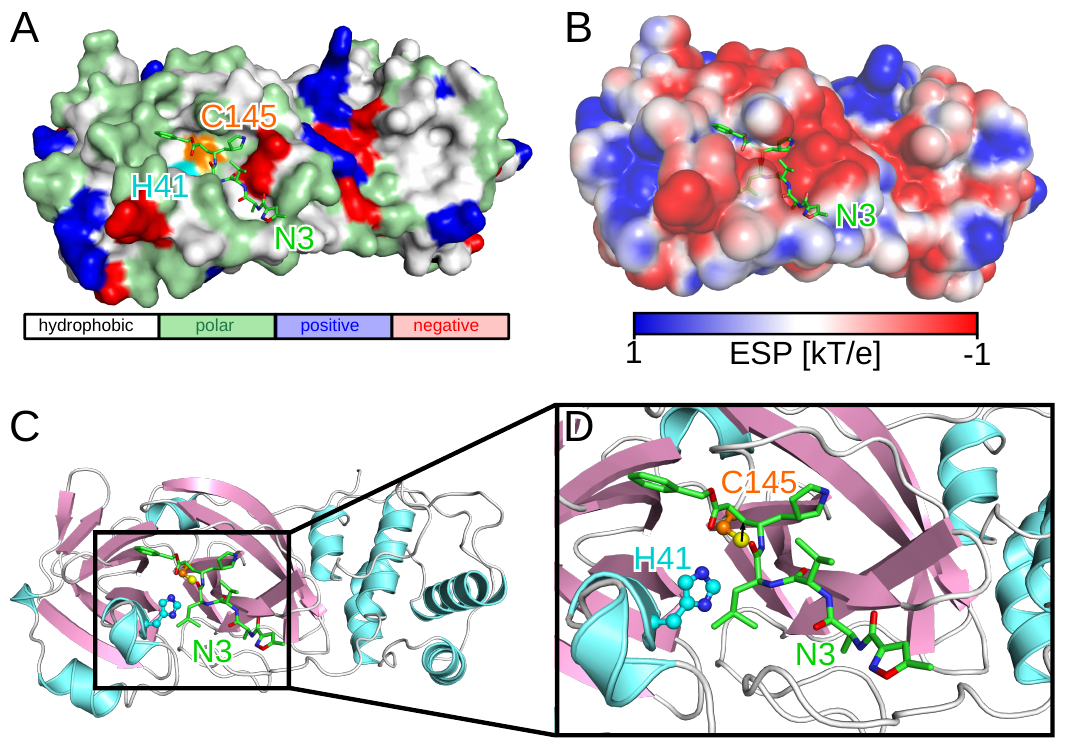
Figure 1. Structure and binding site of 3CL pro including the ligand N3 (PDB code 6LU7). ( A ) The surface of 3CL pro is shown and colored according to residue type using the color code given at the bottom. The catalytic dyad residues H41 and C145 are colored in cyan and orange, respectively. The stick representation is used for N3, which is colored in green with red and blue for the O and N atoms, respectively. ( B ) Another surface representation of 3CL pro but now colored according to the electrostatic potential using the color code given at the bottom (in kT with k being the Boltzmann constant, created with the Adaptive Poisson–Boltzmann Solver (APBS) software [29,30]). ( C ) Cartoon representation of 3CL pro with β -sheets shown in lilac and α -helices in light blue. The sidechains of H41 and C145 are shown in ball-and-stick representation in cyan and orange, respectively, but using blue for N atoms, red for O atoms, and yellow for the S atom of C145. ( D ) Zoom into the substrate binding site of 3CL pro . In panels B–D the same representation for N3 as in panel A is